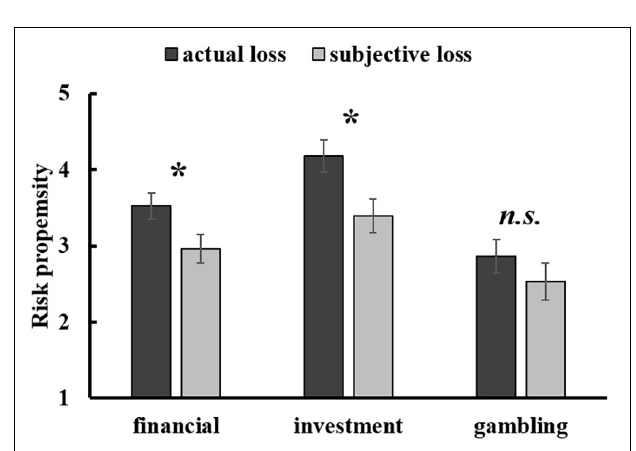
FIGURE 4 | The loss effect on the overall financial risk propensity, risk propensity in investment, and risk propensity in gambling in Study 2. Error bars represent standard errors. n.s. p > 0.05; * p <